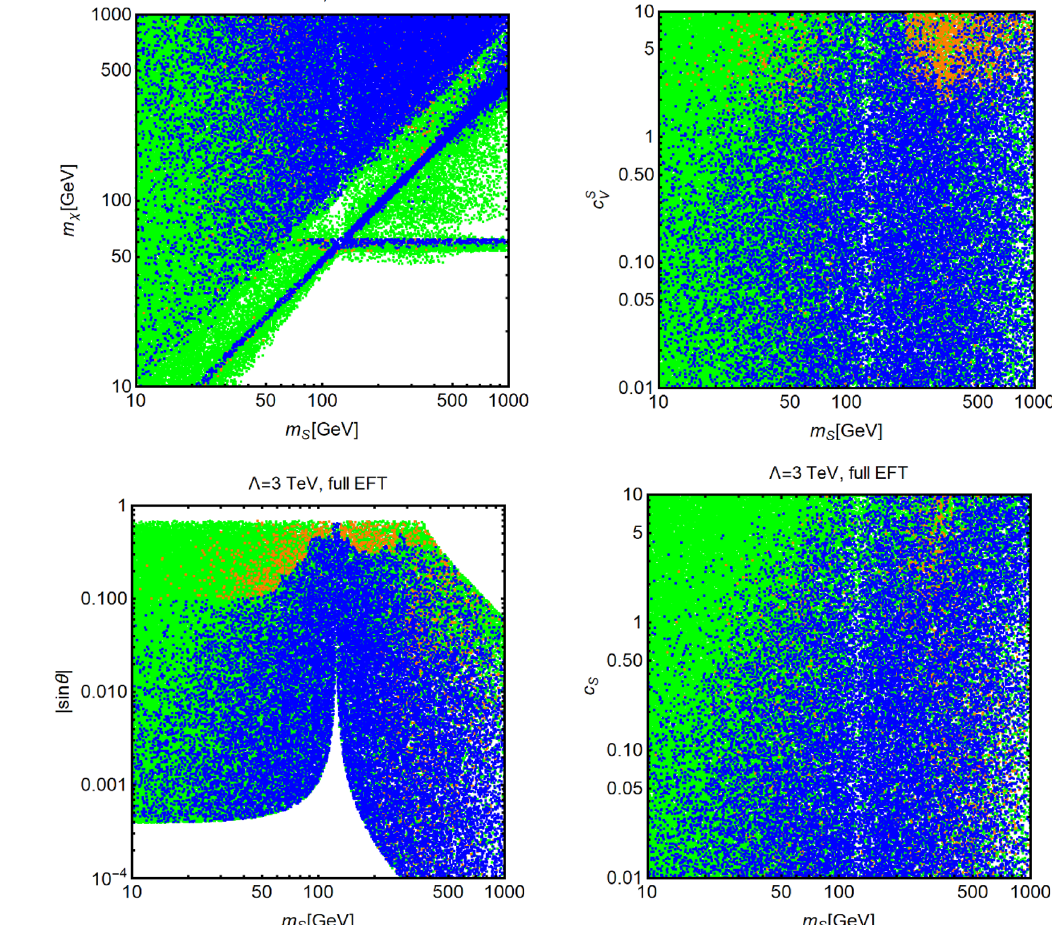
Figure 7 . Results of the parameter scan for the scalar e DMeft setup in the m S (cid:0) m (cid:31) , m S (cid:0) c S m S (cid:0) j sin (cid:18) j , and m S (cid:0) c S planes. The green points provide the correct relic density according to the WIMP paradigm, while the orange points are, in addition, compatible with constraints from DD. The blue points are, (cid:12)nally, also compatible with collider constraints. See main text for details on the scan and the constraints accounted